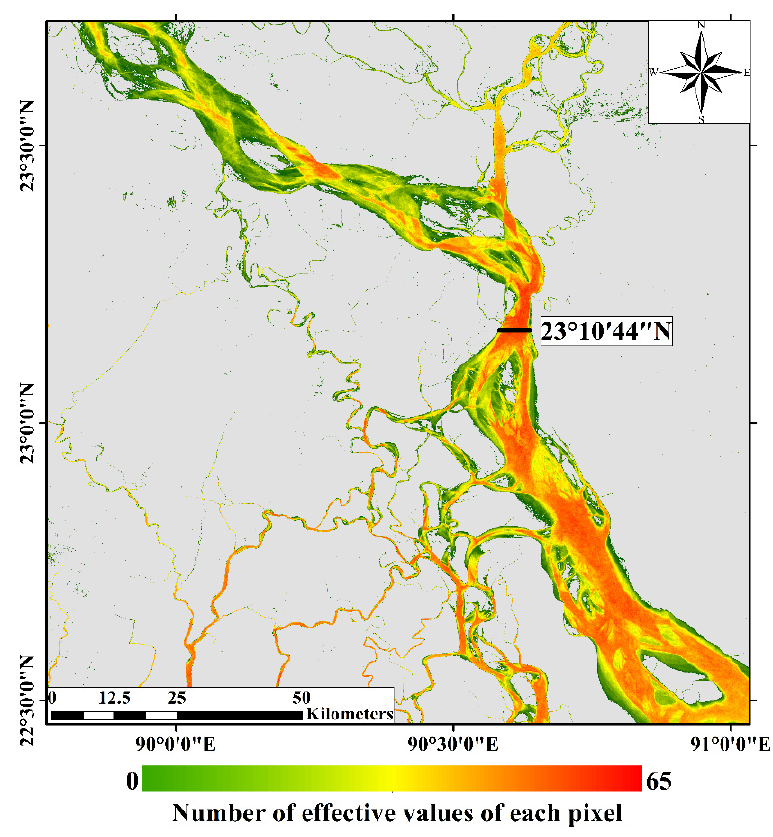
Figure 2. Location of the section selected for calculating F TSM . The color bar shows the number of effective values of each pixel. The section was selected from the branchless part of the river with a relatively large amount of available data. North of the section are mostly input tributaries, while south of the section are mostly distributories. The contributions of the tributaries were also considered when the flux was calculated.